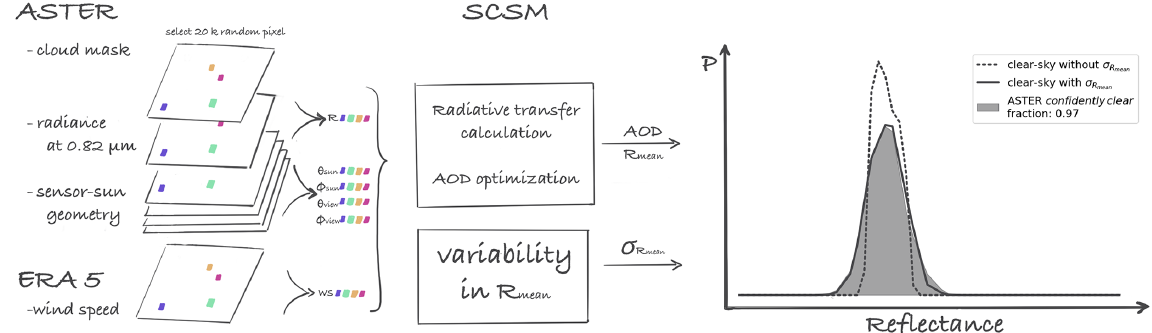
Figure 2. Sketch illustrating the cloud-free retrieval workflow. ASTER and ERA5 input data are used to run radiative transfer simulations with integrated AOD optimization. A Gaussian perturbation is added to the output average pixel reflectance R mean to account for ocean surface variability and measurement noise. On the right are the processing steps that lead to the simulated cloud-free reflectance distribution for a single ASTER image observed on 24 January 2020 at